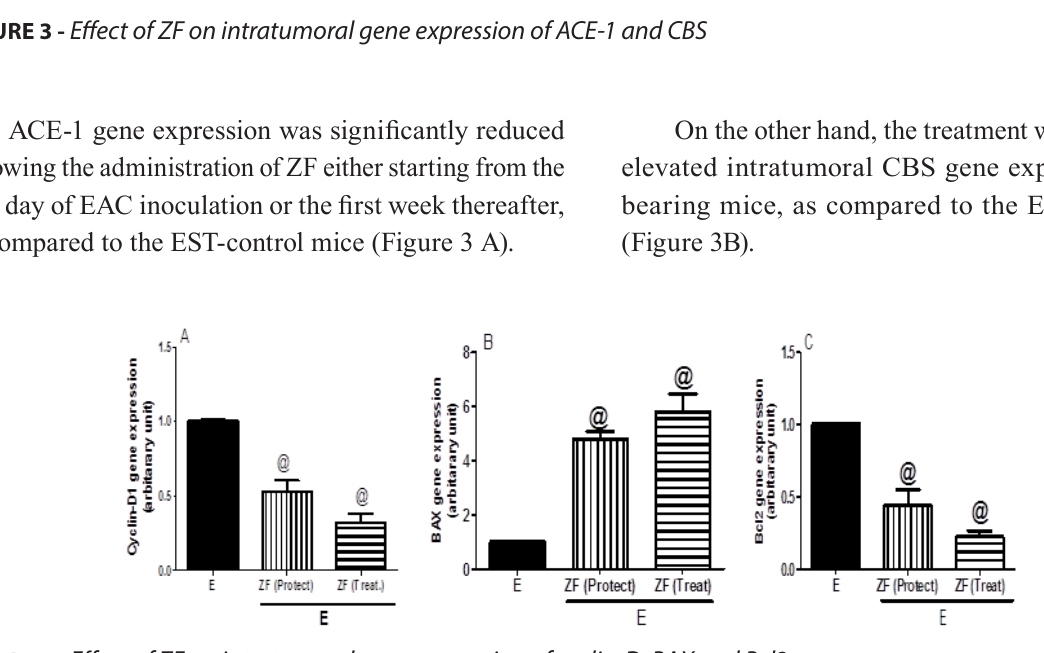
FIGURE 4 - Effect of ZF on intratumoral gene expression of cyclin-D, BAX and